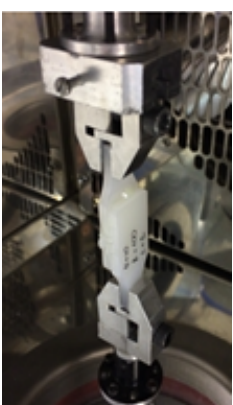
Figure 5. Specimens bonded by the adopted ultra- sonic joining